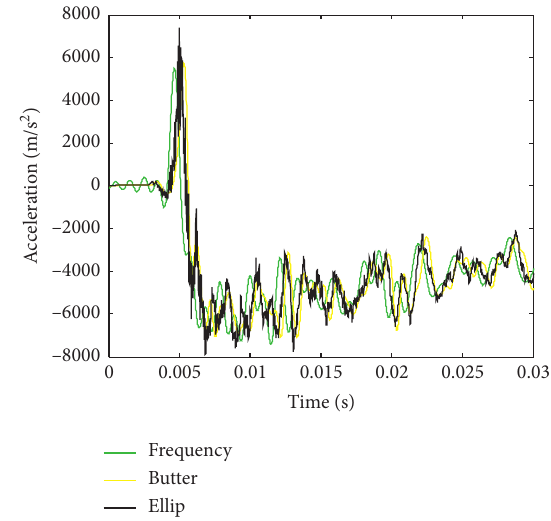
Figure 7: Time-history curve of signal filtered by different filters.